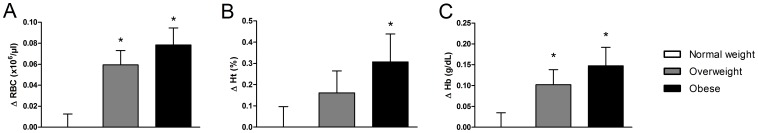
Changes in red blood cells (RBC) (A), hematocrit (Ht) (B) and hemoglobin (Hb) (C) in overweight (OW) and obese relative to Lean body mass index subgroups.*: p<0.05 vs. Lean.